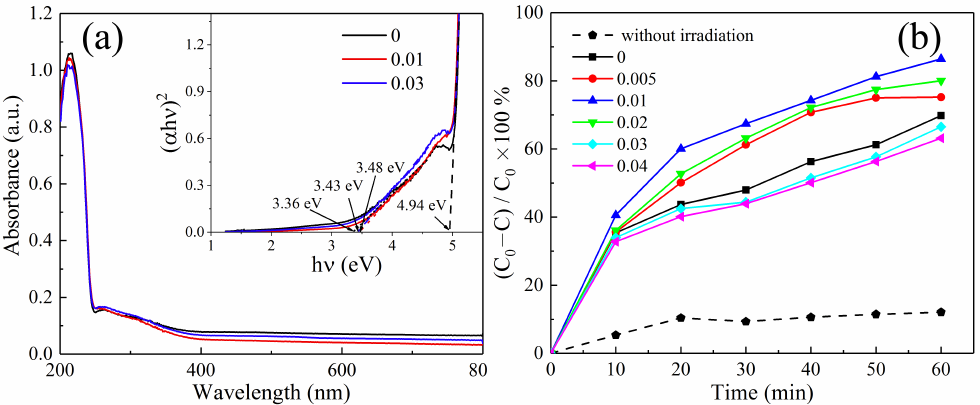
Figure 7. Physical properties of HT-ZrO 2 ( x ) particles ( a ) UV-Vis absorption spectrum, ( b ) photocat- alytic degradation of